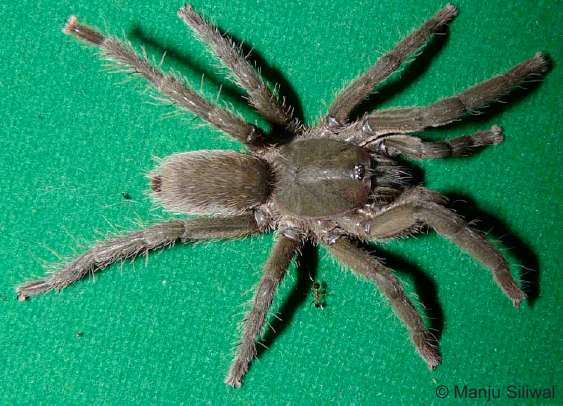
Image 5. Female of Neoheterophrictus uttarakannada sp. nov. (Holotype,